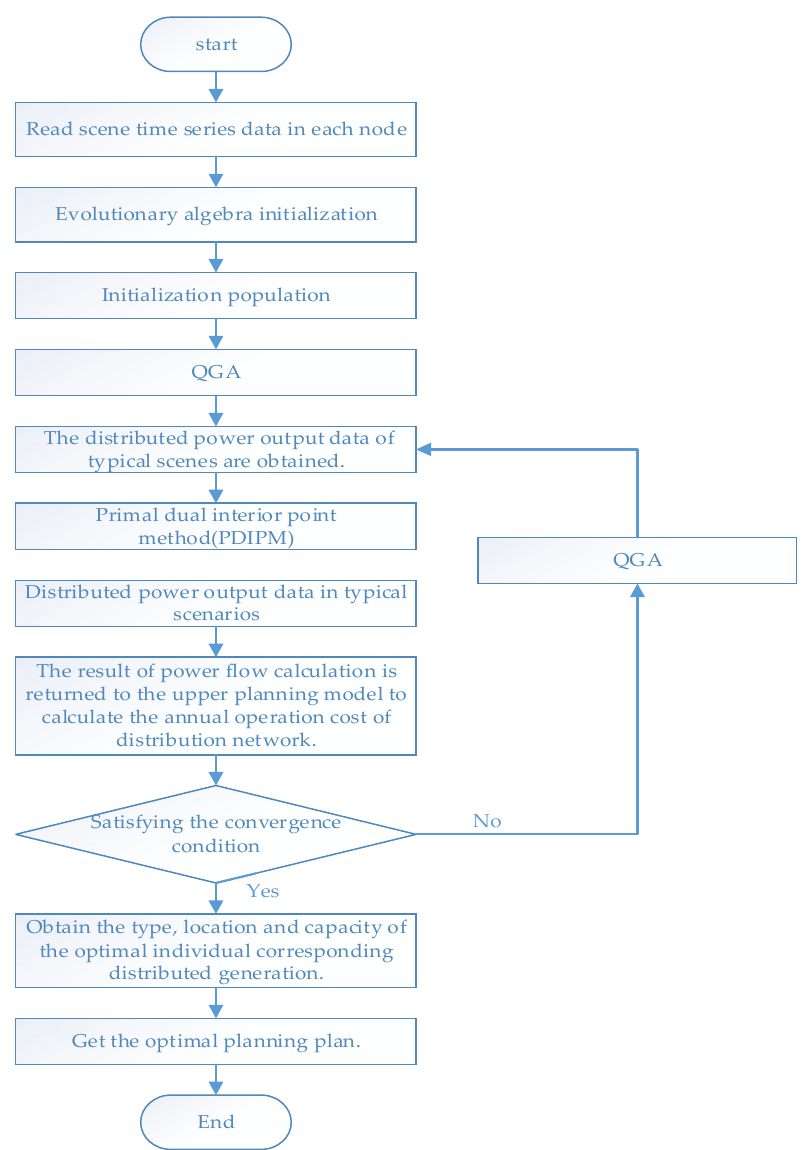
Figure 7. Process of the bilevel optimal allocation model. QGA: quantum genetic algorithm.